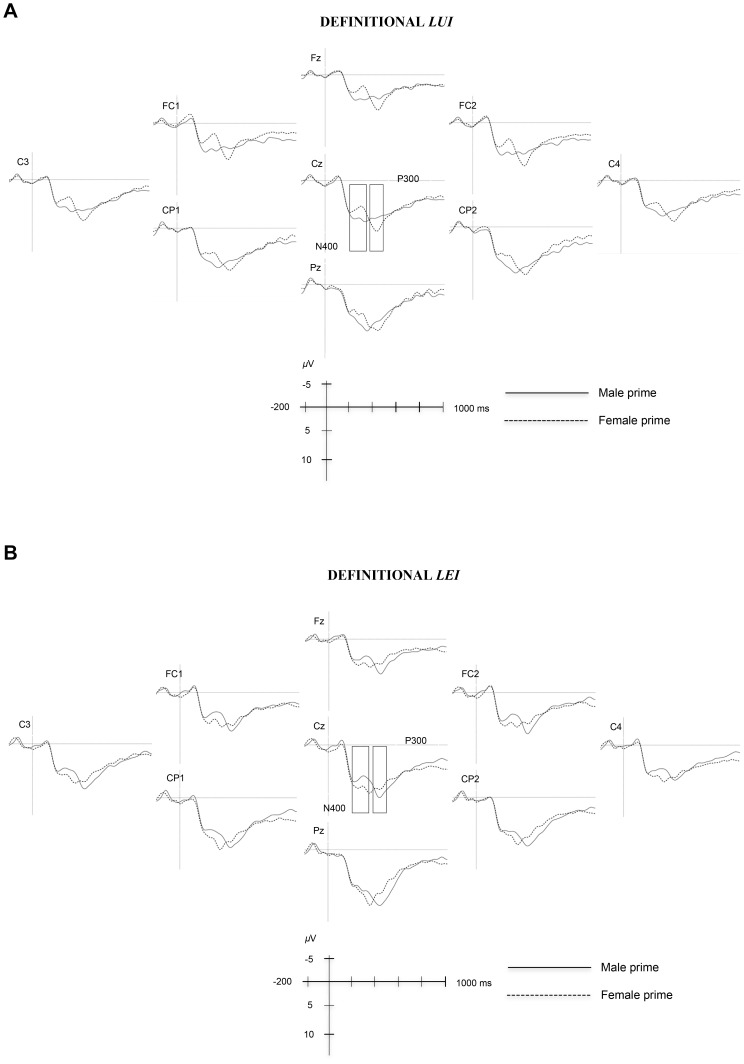
Mean amplitudes evoked by masculine pronouns (lui – “he”) (A) and feminine pronouns (lei – “she”) (B) after male and female definitional primes (n = 25). Zero point is the onset of the pronoun. Amplitudes are provided for representative electrodes only. Negativity is plotted upwards.